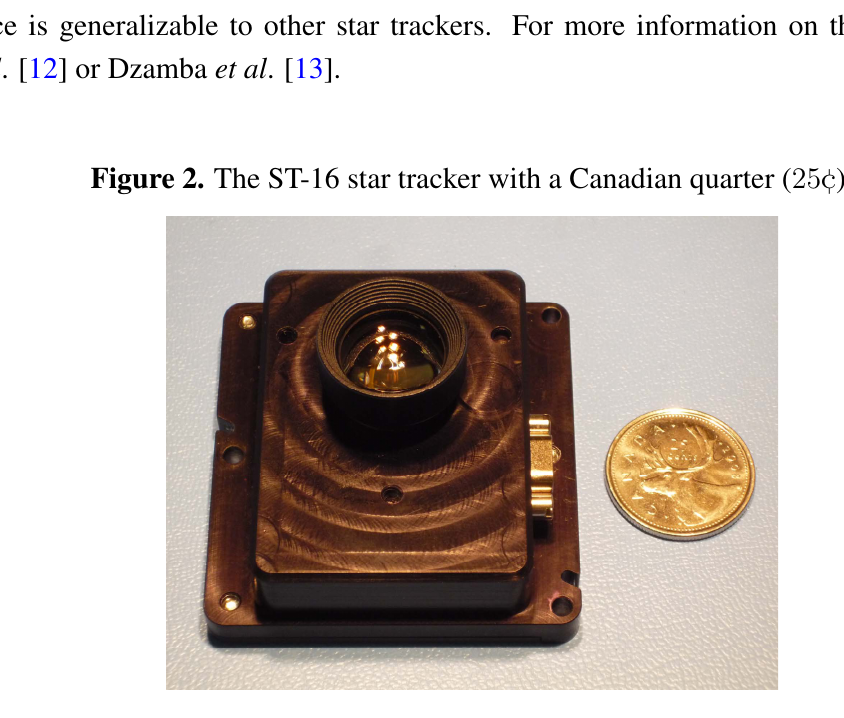
Figure 2. The ST-16 star tracker with a Canadian quarter ( 25